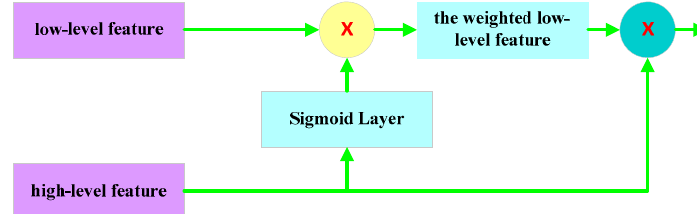
Figure 3. The architecture of the spatial attention features fusion module.